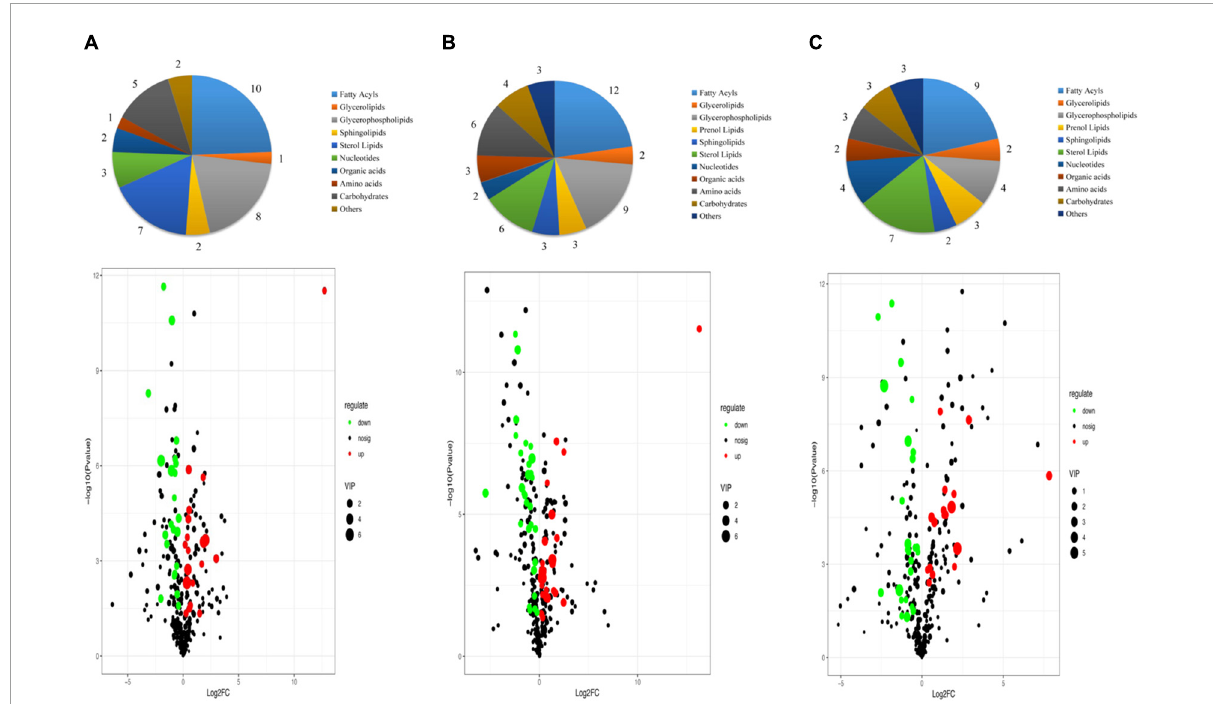
FIGURE2 Classification and volcano plot of the differential compounds in different samples: (A) CD vs. ED, (B) CD vs. FD, (C) ED vs. FD.